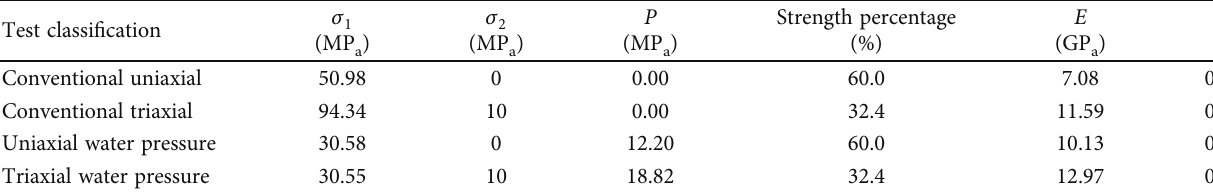
Table 1: Test programs and